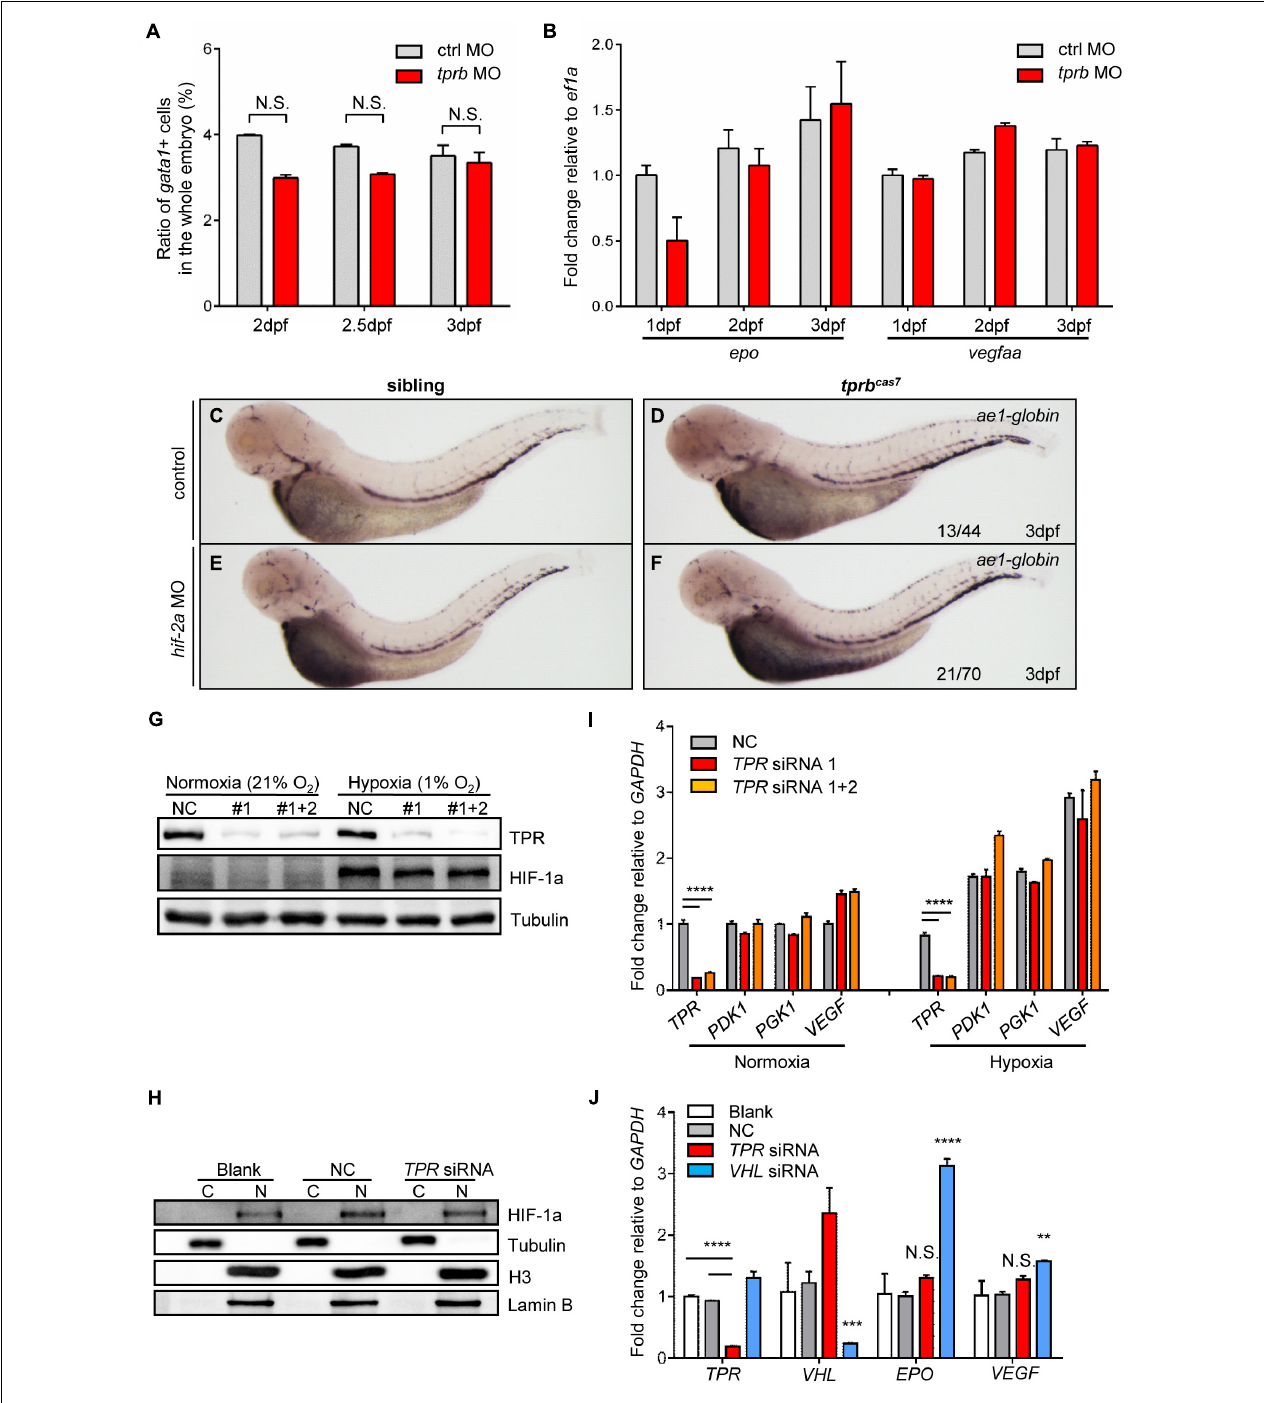
FIGURE 4 | HIF signaling is not activated in tprb cas 7 mutant. (A) The statistic results of the ratio of gata1 + cells sorted by flow cytometer in the whole embryo of control and tprb morphants by Tg(gata1: DsRed; kdrl: EGFP) transgenic line at different time points. (B) Quantitative PCR results of epo and vegfaa in control and tprb morphants at different time points. (C–F) WISH analysis of ae1-globin expression in sibling and tprb cas 7 mutants at 3 dpf under the control and hif-2a morpholino (E,F) injection. (G) Immunoblotting analysis of TPR and HIF-1a protein level in whole HEK293T cells under normoxia and hypoxia conditions during TPR knockdown through siRNA. (H) Immunoblotting analysis of HIF-1a protein level in the nuclei of HEK293T cells under hypoxia condition after nuclear and cytoplasmic separation. C, cytoplasma; N, nucleus. (I) Quantitative PCR results of HIF target genes including TPR, PDK1, PGK1 , and VEGF in HEK293T cells during TPR knockdown through siRNA. (J) Quantitative PCR results of HIF target genes including EPO and VEGF in Hep3B cells during TPR or VHL knockdown through siRNA under hypoxia condition. NC: negative control. #1: TPR siRNA 1; #1 + 2: TPR siRNA 1 + 2. Error bars represent SEM. N.S.: not significant; ** p ≤ 0.01; *** p ≤ 0.001; **** p ≤